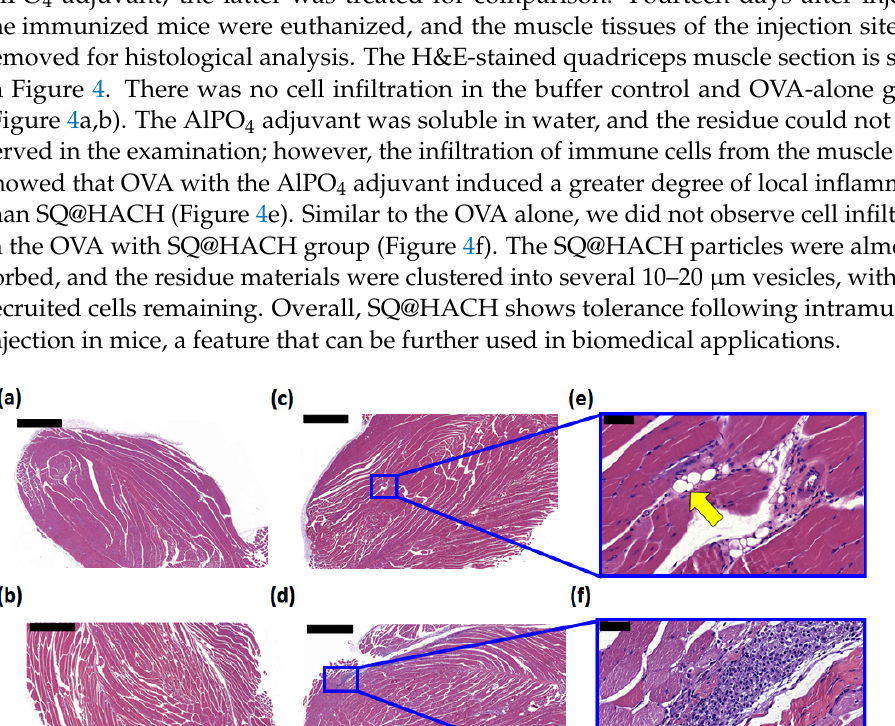
Figure 3. The changes of visual appearances, particle size and polydispersity index (PDI) of SQ@HACH upon storage at ( a ) 4 °C for 20 weeks and ( b ) 37 °C for 20 weeks. The diameter and PDI of SQ@HACH (100-fold dilution) were measured by DLS. (n = 3, mean ± SD).